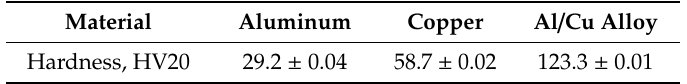
Table 1. Vickers hardness of aluminum, copper and Al / Cu alloy surface.